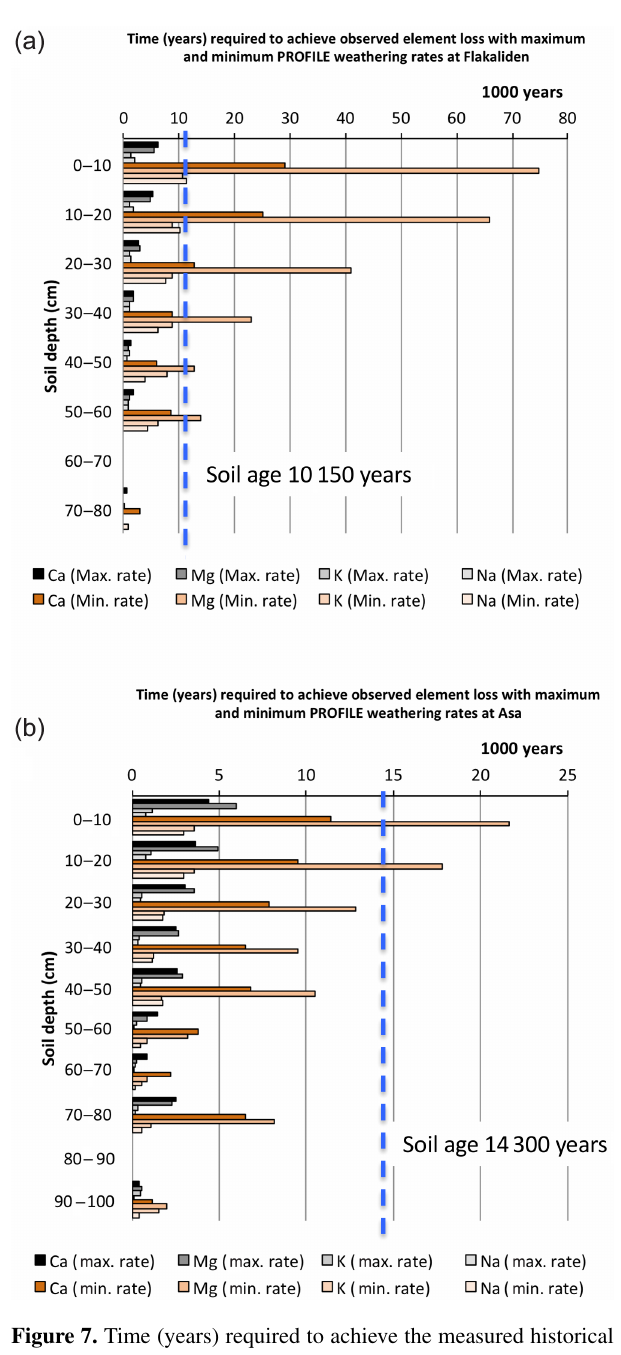
Figure 7. Time (years) required to achieve the measured historical element loss in different soil horizons with application of maximum or minimum PROFILE weathering rates at (a) Flakaliden and (b)